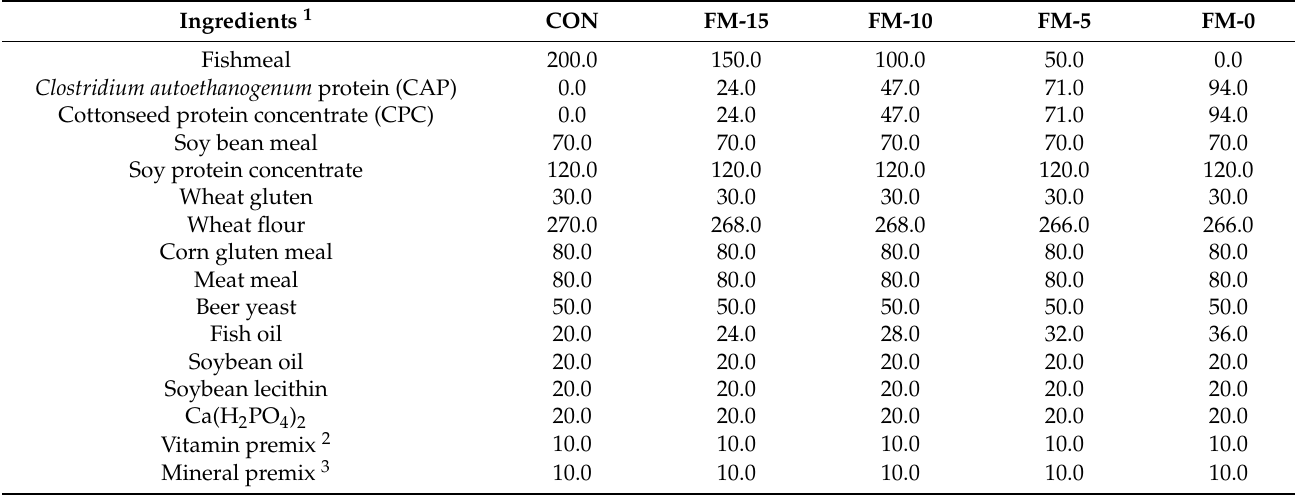
Table 1. The diet formulation and proximate composition (air-dry basis,